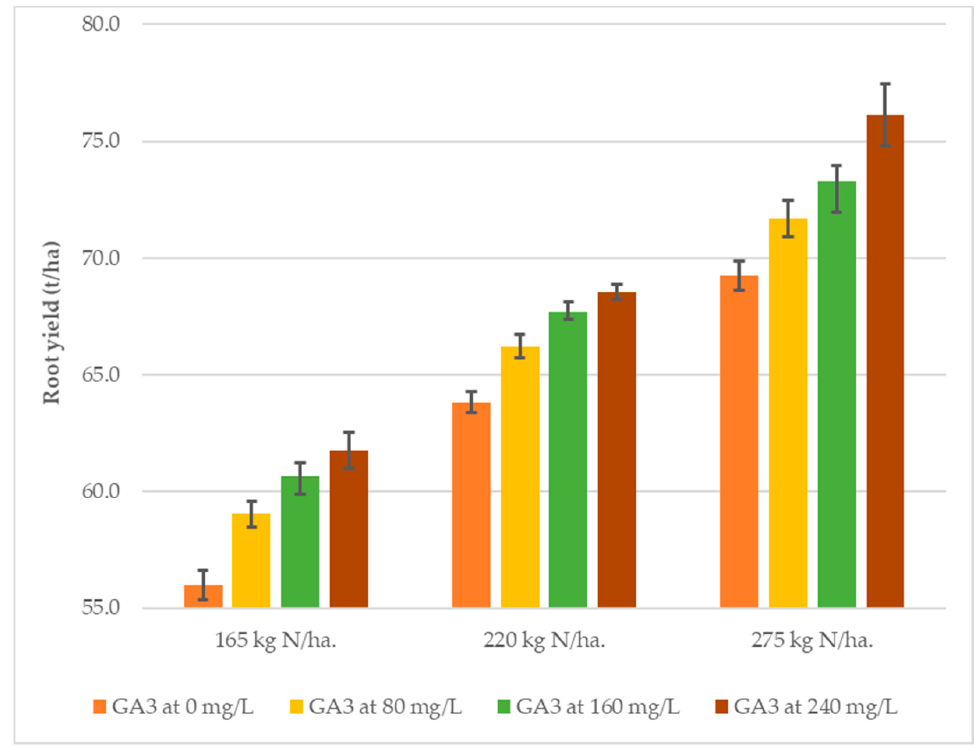
Figure 4. Root yield (t/ha) as affected by the interaction between nitrogen fertilizer levels and GA 3 spraying concentrations in the second season (2015/2016).